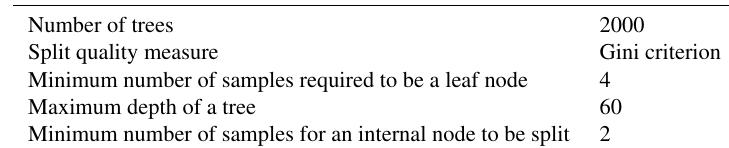
Table B3. Random forest